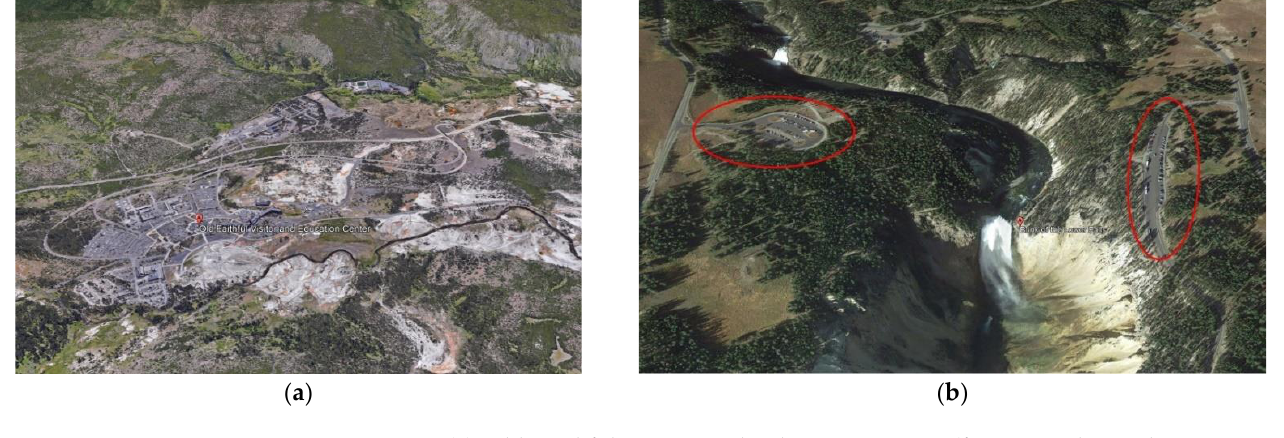
Figure 16. ( a ) Old Faithful Visitor and Education Centre (from Google Earth Pro V 7.3.4, (19 June 2016), 44°27′29.56″N, 110°49′45.32″W, Eye alt 3.34 km, Landsat, Copernicus, Maxar Technolo- gies/USDA/FPAC/GEO 2022, [46]); ( b ) brink of the lower fall: the parking sites in the left and